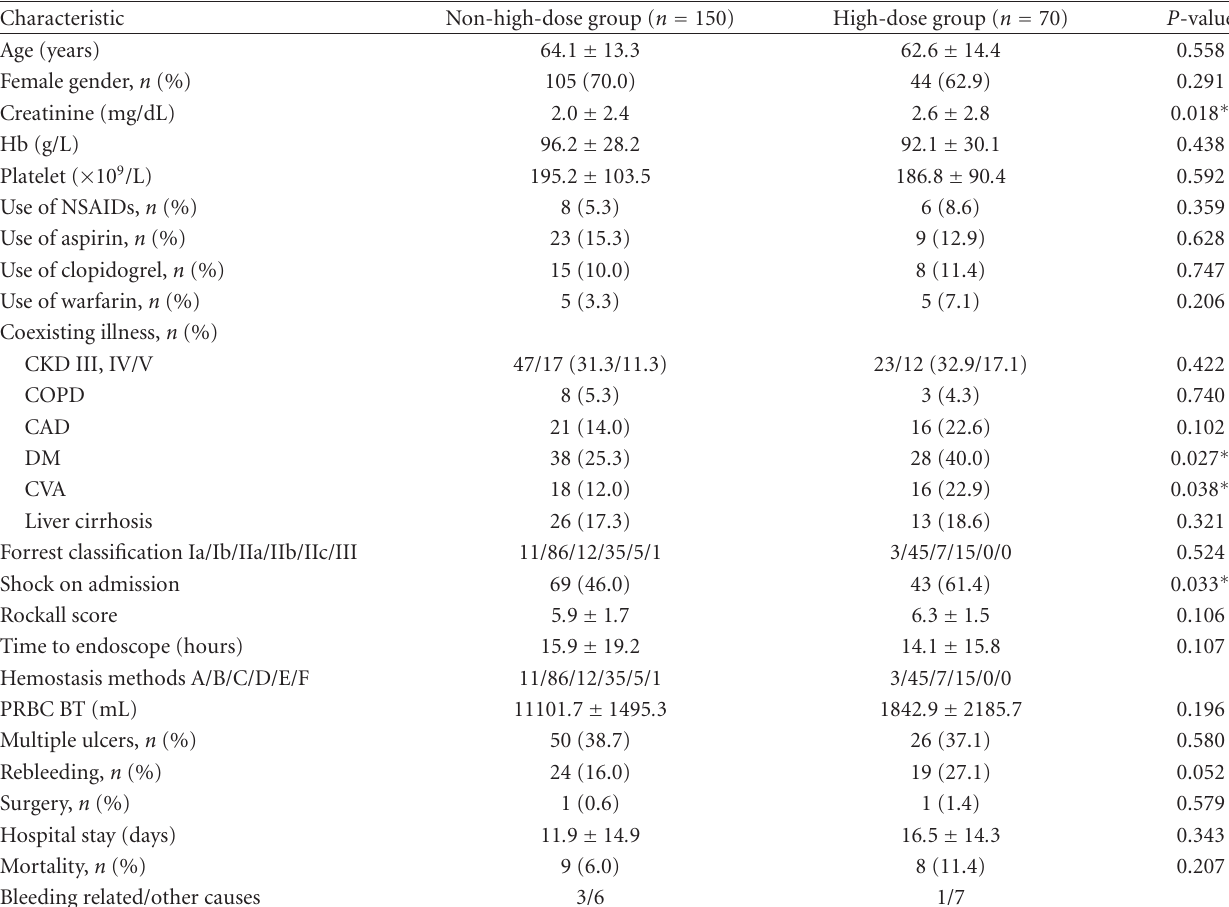
Table 3: Comparison between the non-high-dose and high-dose PPI before case-controlled matching.